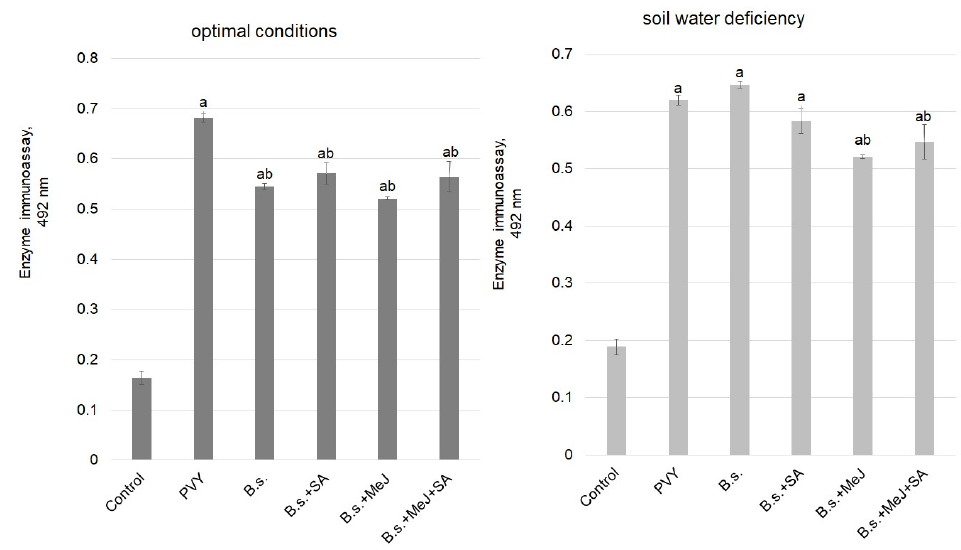
Figure 1. Detection of PVY by ELISA in the sap of potato leaves after application mixture of B. subtilis with SA and MeJ. Control—health plants; PVY—infected with PVY plants; B.s.— B. subtilis + PVY; B.s. + SA— B. subtilis + salicylic acid + PVY; B.s. + MeJ— B. subtilis + methyl jasmonate + PVY;